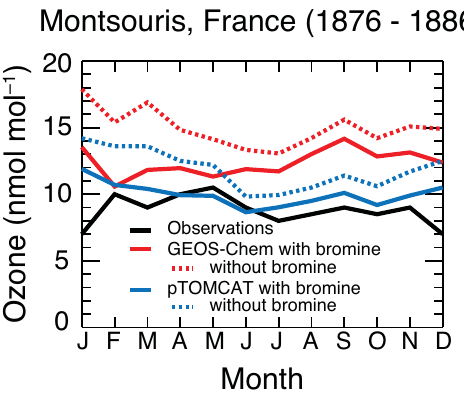
Fig. 6. Decrease in tropospheric ozone (nmolmol − 1 ) from bromine chemistry. The figure shows zonal seasonal mean differences between GEOS-Chem simulations including vs. not including bromine chemistry. Shading indicates the stratosphere.